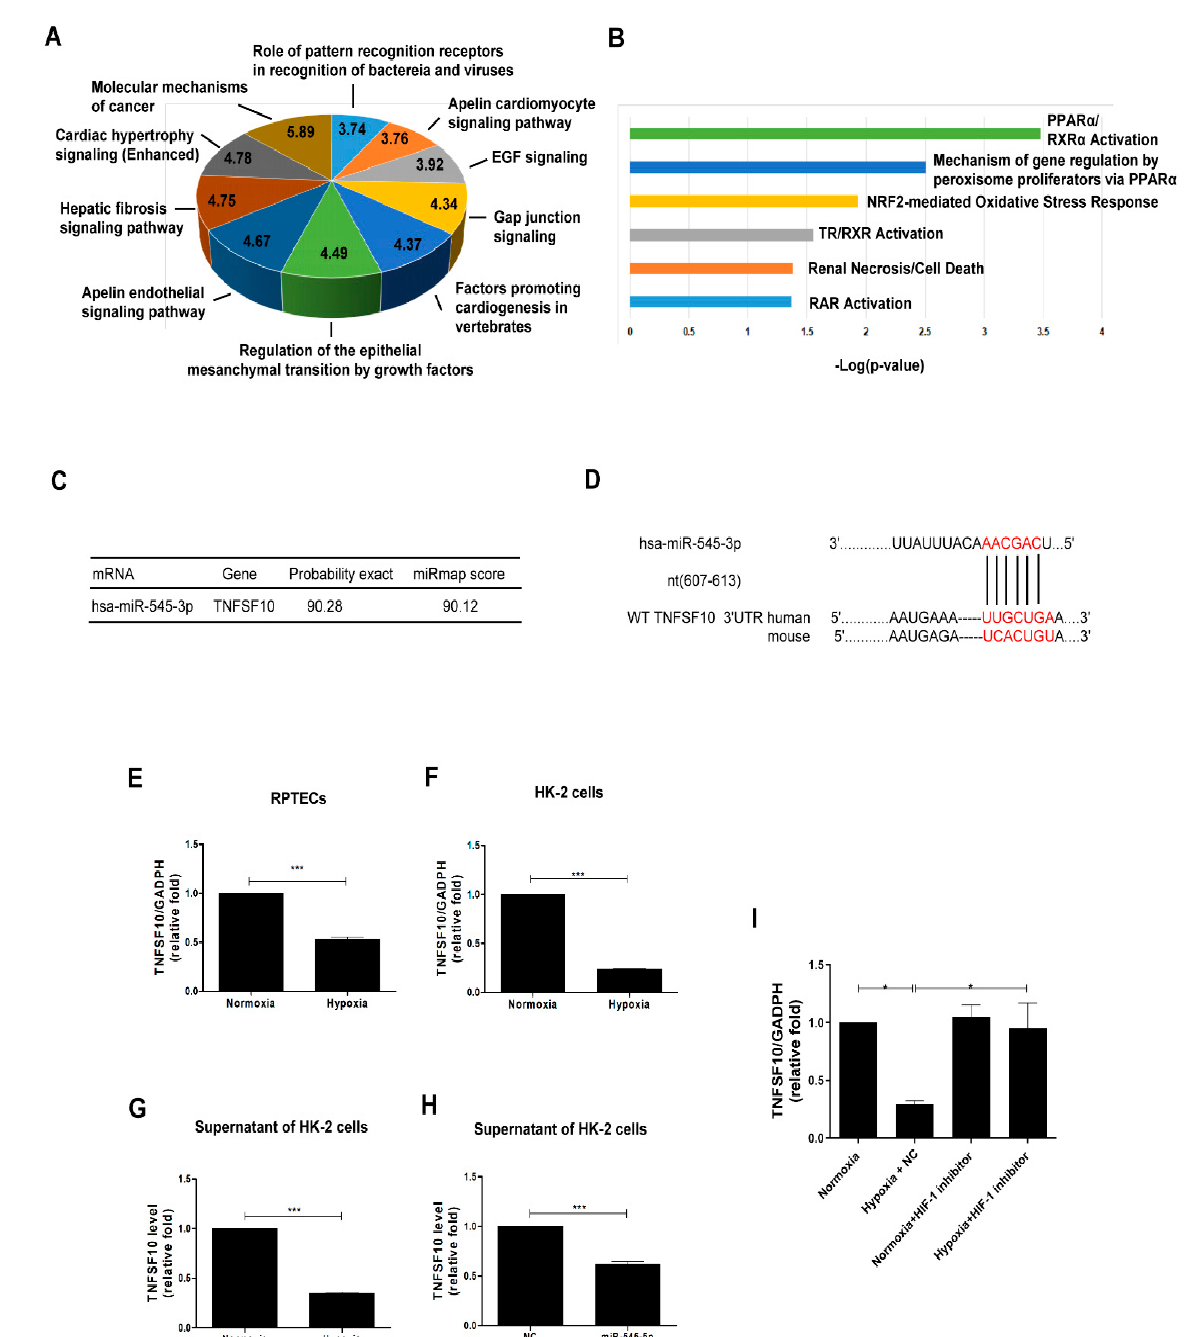
Figure 3. TNFSF10 as a direct target of miR-545-3p. ( A ) Top ten canonical pathways of the potential genes targeted by miR-545-3p using IPA analysis. The pie chart indicates the-Log10 (false discovery rate, FDR) of each canonical pathway. ( B ) Tox list analysis of potential genes targeted by miR-545-3p according to IPA analysis. ( C ) The predictive binding score of miR-545-3p on 3 (cid:48) UTR of TNFSF10 mRNA according to the miRmap database. ( D ) A schematic representation of sequence alignment of TNFSF10 mRNA 3 (cid:48) UTR based on TargetScan version 7.2. TNFSF10 mRNA levels in human RPTECs ( E ) and HK-2 cells ( F ) under normoxia and hypoxia for 48 h were examined using quantitative real-time PCR. The TNFSF10 protein expressions of the supernatants of the HK-2 cells cultured under hypoxia ( G ) or after transfection with miR-545-3p ( H ) for 48 h were assessed by ELISA. TNFSF10 mRNA expression was also examined in HK-2 cells treated with HIF-1 inhibitor (10 uM) under normoxia and hypoxia for 48 h by quantitative real-time PCR ( I ). The bar graph represents the mean ± SEM of at least three independent experiments. * p < 0.05, *** p < 0.001 by Student’s t -test. WT, wild